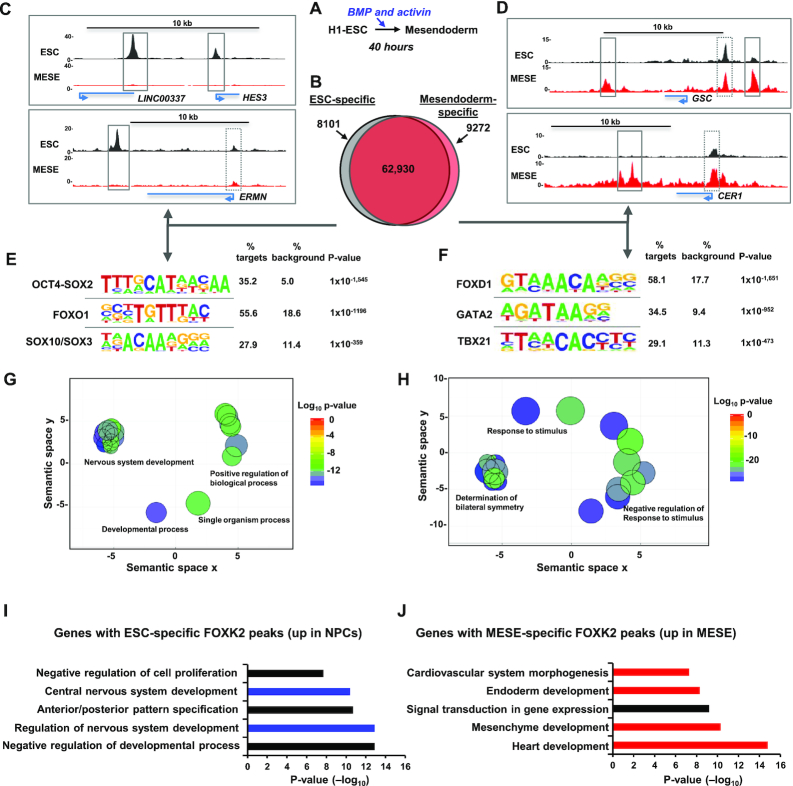
Identification of cell type-specific FOXK2 binding events. (A) Schematic view of the mesendoderm differentiation protocol. (B) Venn diagram showing the overlap of FOXK2 binding regions in ESCs and mesendodermal (MESE) cells. (C and D) UCSC genome browser view of FOXK2 ChIP-seq binding profiles in ESCs or MESE cells around the indicated loci. Cell type-specific (solid line) and common (dotted line) regions bound by FOXK2 are boxed. (E and F) De novo motif discovery in ESC-specific (E) and MESE-specific (F) FOXK2 binding regions. (G and H) Gene ontology enrichments for genes associated with ESC-specific (F) and MESE-specific (H) binding regions. GO terms are reduced and clustered in semantic space based on their semantic similarities and a single representative GO term is selected for each cluster, using the online tool REVIGO. (I) and (J) Gene Ontology categories enriched in genes associated with ESC-specific (I) or MESE-specific (J) FOXK2 peaks and showing upregulation (>2-fold change and >10 RPKM) in either NPCs (I) or MESO (J) cells. Data are ranked according to P-values.